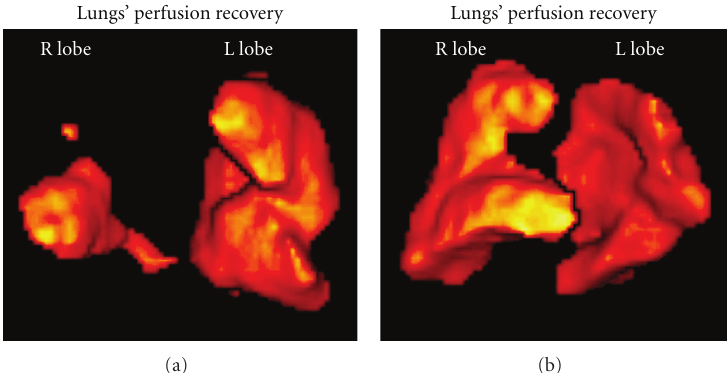
Figure 12: 3D SPECT Lungs’ FBP reconstruction by Hann filter (critical frequency 0.9) and Chang attenuation correction order 0, coe ffi cient 0.11. (a) 4 hours postevent, Right lobe embolism, R lobe volume 0.66 lt, and total lungs’ volume 2.85 lt. (b) 11 days posttherapy, R lobe volume 3.28lt, and total lungs’ volume 5.28lt. [37] (modified) .